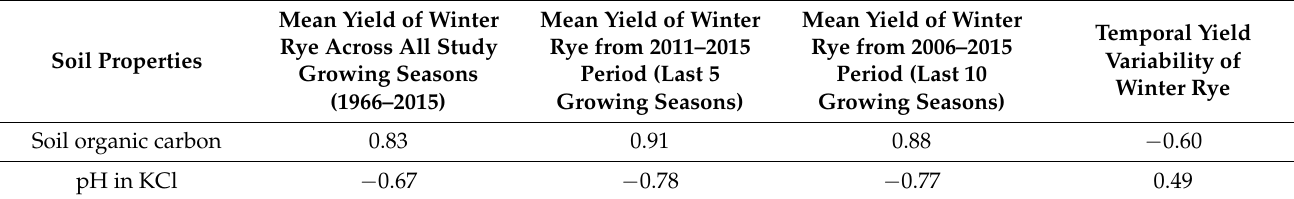
Table 3. Spearman rank correlation coefficients between mean yield, temporal yield variability of winter rye and two selected soil properties (Skierniewice LTE